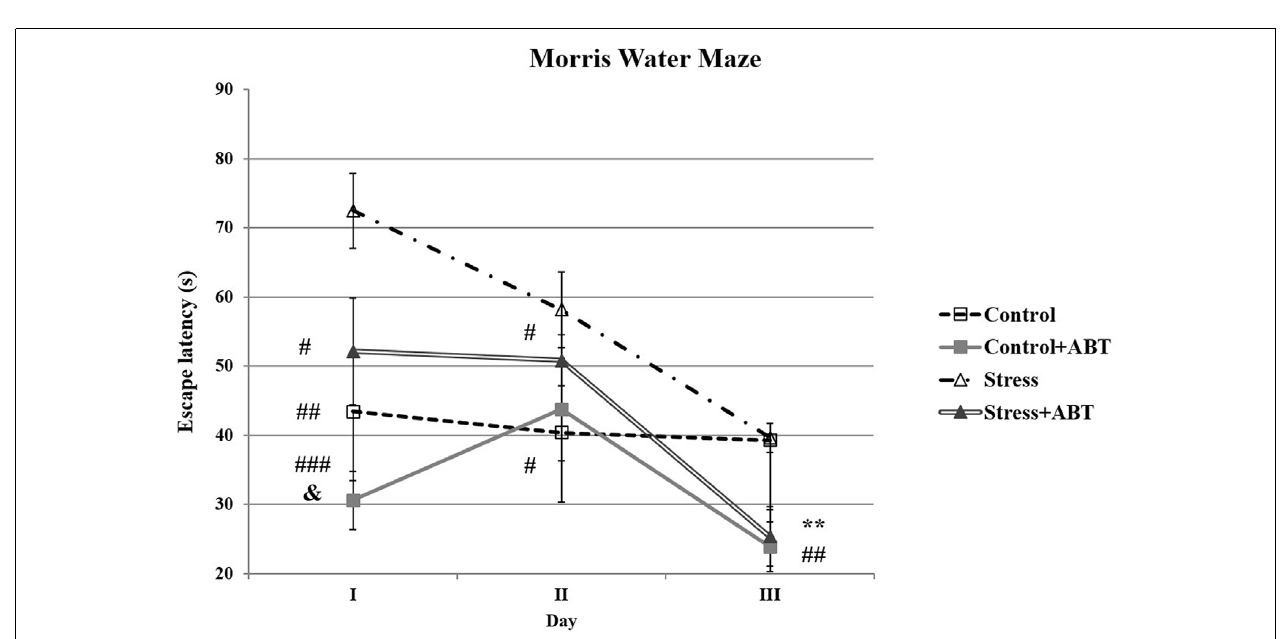
FIGURE 2 | Effects of chronic stress and long-term ABT-239 pre-treatment on performance in spatial memory test of the Morris water maze (MWM) task. Each point of the graph represents the mean ± SEM of three trials (three trials per day for 3 days) obtained from n rats indicated at the bottom of the figure. On day I, three groups of rats demonstrated significantly different results in comparison with stress: # p < 0.05 vs. Stress + ABT, ## p < 0.01 vs. Control and ### p < 0.001 vs. Control + ABT. Statistically significant differences were also in & p < 0.05 Control + ABT vs. Stress + ABT. On day II, significantly different results were obtained: Control vs. Stress ( # p < 0.05) and Stress vs. Stress + ABT ( # p < 0.05). On day III, statistically significant differences were: Control vs. Control + ABT and Control vs. Stress + ABT (** p < 0.01), as well as Stress vs. Stress + ABT and Stress vs. Control + ABT ( ## p <